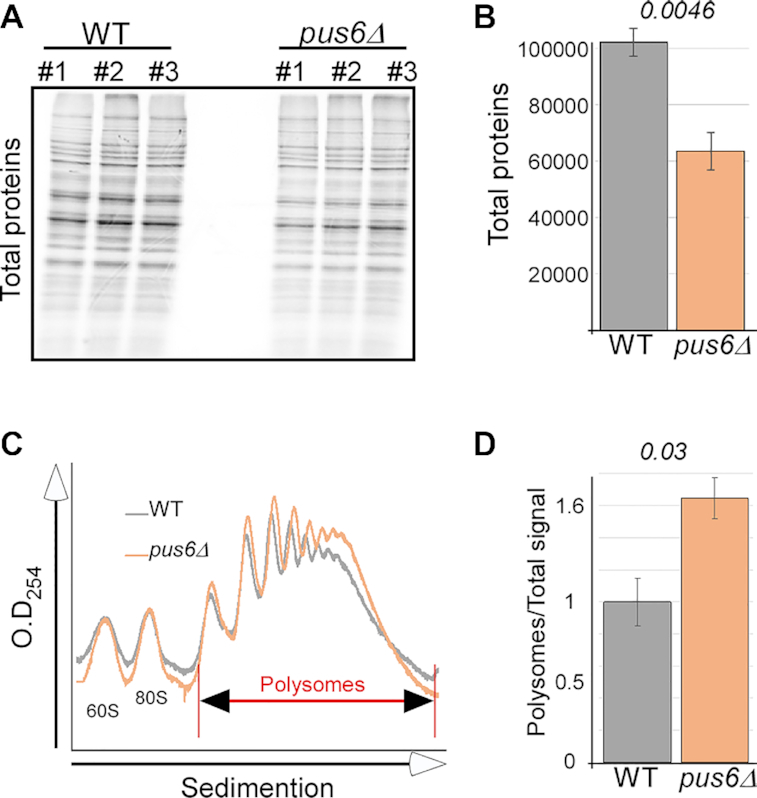
Pus6 deletion affects global translation. (A) pus6Δ or its isogenic parental strain (WT) were grown to the same logarithmic OD and pulse-labelled with 35S-met. Protein samples were collected after 30 min and resolved by SDS-PAGE. Gels were exposed to a phosphorimager. Protein samples from three independent biological repeats (#1 to #3) are presented. (B) Quantification of three independent biological repeats of total proteins signal. Error bars represent SEM, and P-value was calculated by the dependent samples two-tailed t-test. (C) WT and pus6Δ cells were subjected to polysomal analysis on sucrose gradients. OD254 was monitored throughout the gradient, and the sedimentation position of polysomal complexes (>2 ribosomes) is indicated. (D) Quantification of the polysomal fractions signal from three independent biological repeats. Error bars are SEM, P value was determined by the dependent samples two-tailed t-test. Blots are presented in Supplementary Figure S3C.